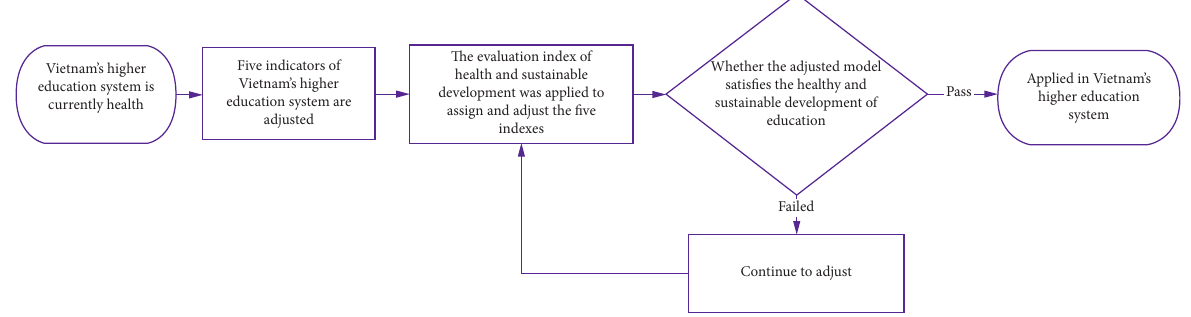
Figure 6: Flowchart of model operation process. Table 5: Health weights of higher education in